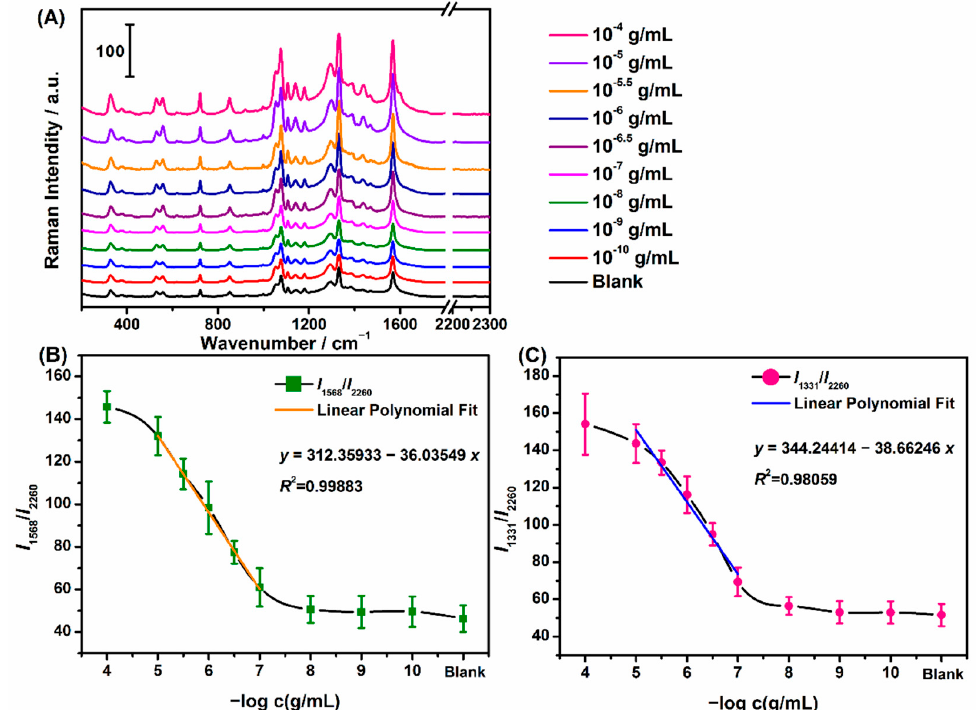
Figure 6. ( A ) Benzocaine concentration-dependent SERRS spectra of the corresponding azo com- pound. The intensity ratio of SERRS peaks at 1568 cm − 1 ( B ) and 1331 cm − 1 ( C ) to 2260 cm − 1 versus the negative log concentration of benzocaine. Each error bar indicates the standard deviation of the SERRS intensity ratio. The error bars were made with at least five sets of data.